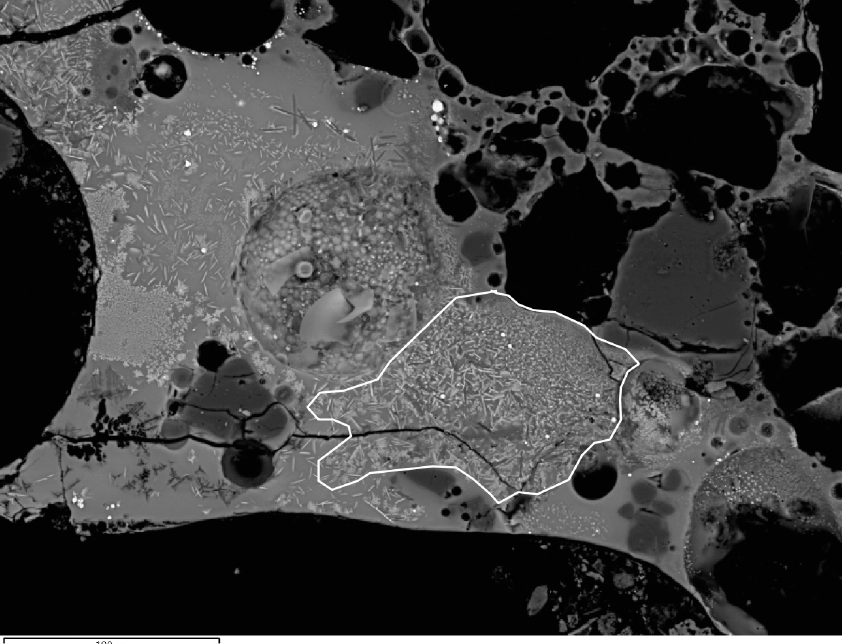
Fig 9. BSE micrograph of G11 showing a cluster of delafossite needles in the middle of the sample. It is indicated with a white line. (Scale = 100 μ m).